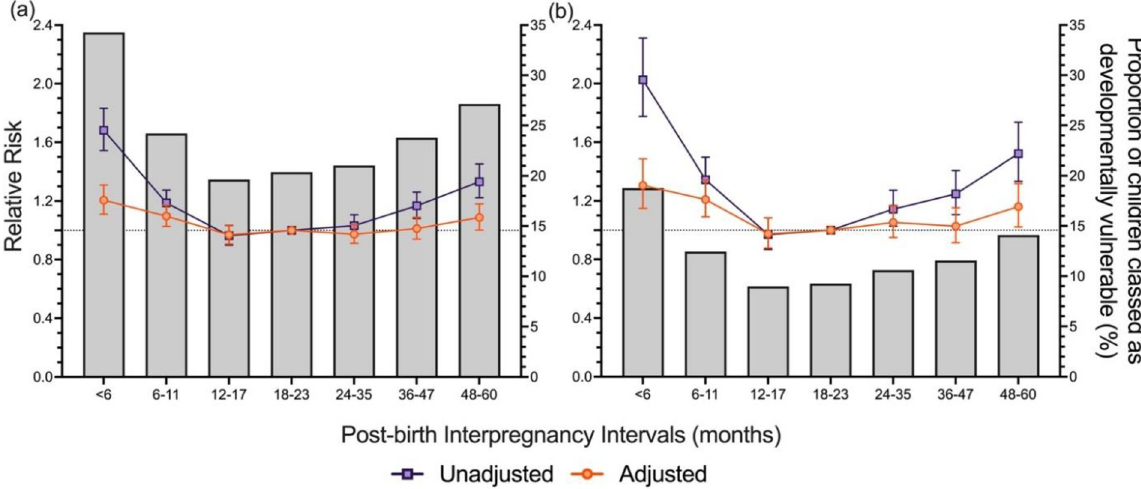
Fig 2. Unadjusted and adjusted relative risk for the association between developmental vulnerability on the Australian Early Developmental Census (AEDC) and post-birth interpregnancy intervals (IPIs). Post-birth IPI was defined as the time between the birth of the child in the cohort and the start of pregnancy of their next youngest sibling (birth date of cohort child minus gestational age of the subsequent child, measured in completed weeks of gestation). The proportion of the study population classified as developmentally vulnerable (a) on one or more AEDC domains, and (b) on two or more AEDC domains, overlayed with the relative risk for each outcome. Developmental vulnerability was defined as scores in the bottom decile, based on the 2009 AEDC cut-offs. Adjusted model based on pooled analysis from 20 imputed datasets, controlling for; the sex of child and age of the child at the time of AEDC completion, maternal smoking status during pregnancy, preterm birth, small for gestational age, parity, maternal age at the time of child’s birth, the child speaks a language other than English at home, ethnicity of the child, preschool attendance, maternal marital status at the time of child’s birth, maternal and paternal occupation status, Accessibility and Remoteness Index of Australia category, Index of Relative Socioeconomic Disadvantage category. All data is presented with 95% confidence intervals: modified Poisson